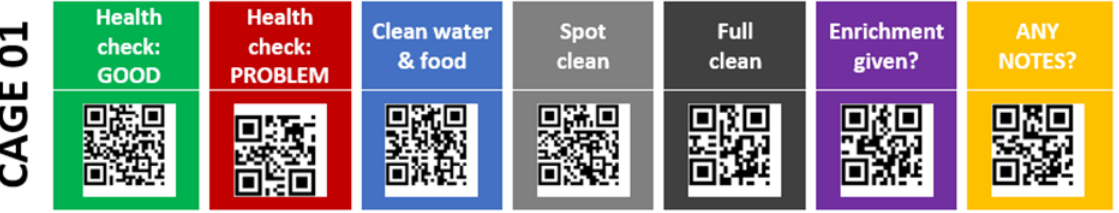
Once printed, these tags are cut out, with each cage’s tags in a single strip and laminated for long- term durability. I used an inexpensive thermal laminator to protect the tags. Tag strips are laminated with 5 mil laminator pouches. Laminators are widely available for $20-60 USD (e.g., Apache AL13